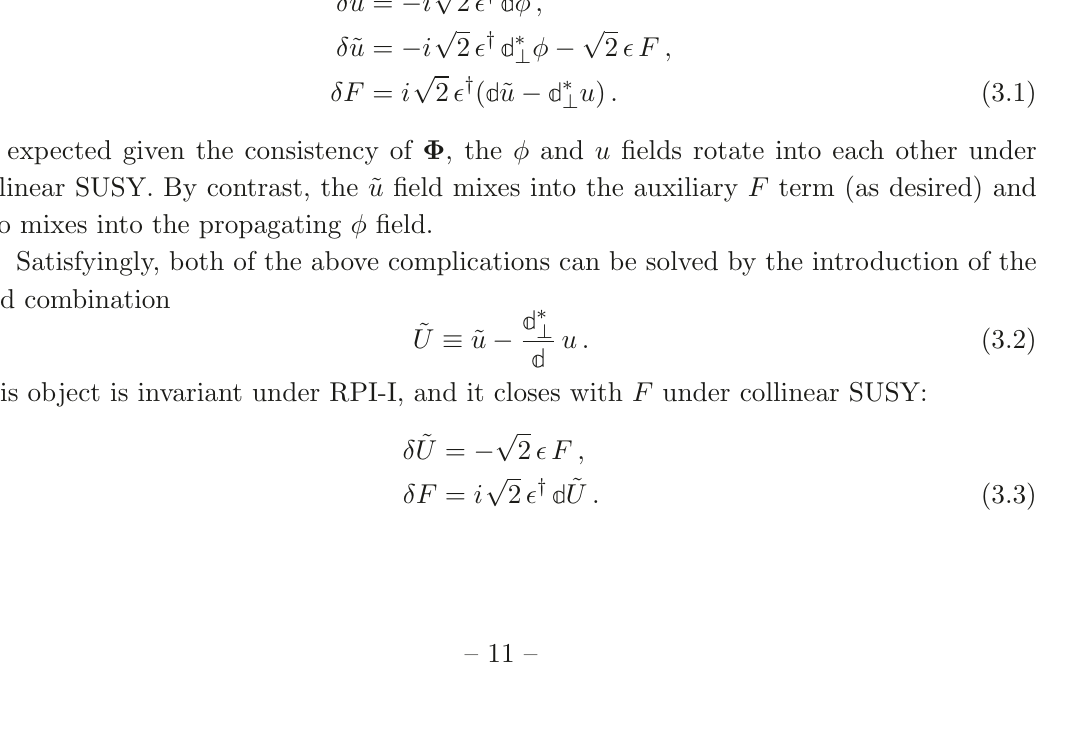
Table 2 . The RPI transformations for the chiral matter degrees of freedom. Here, u component of the fermion along the light cone and ˜ u the spectrum, RPP-II is linearly